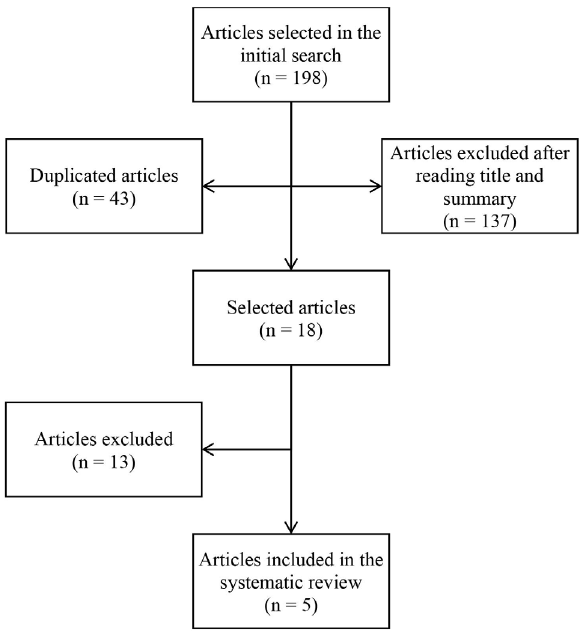
Figure 1 - Flow diagram of the article selection